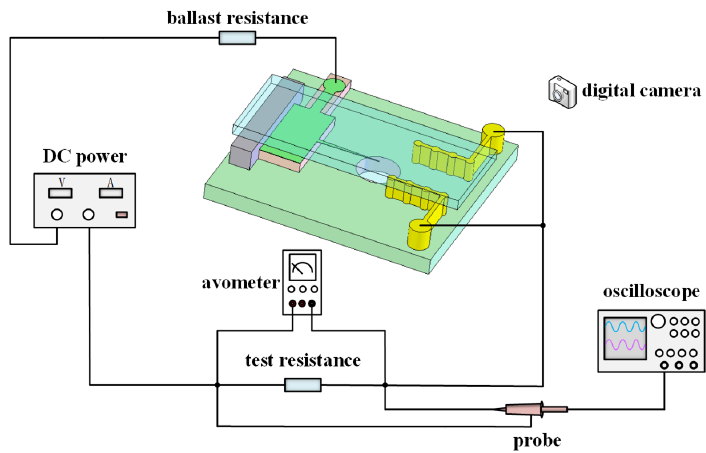
Figure 3. Experimental setup of the discharge circuit.